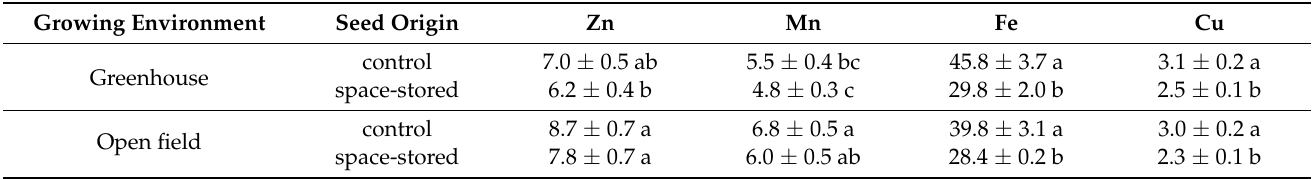
Table 5. Elemental composition of tomato fruits obtained from control and spaceflight-exposed seeds, in greenhouse and in open field (mg kg − 1